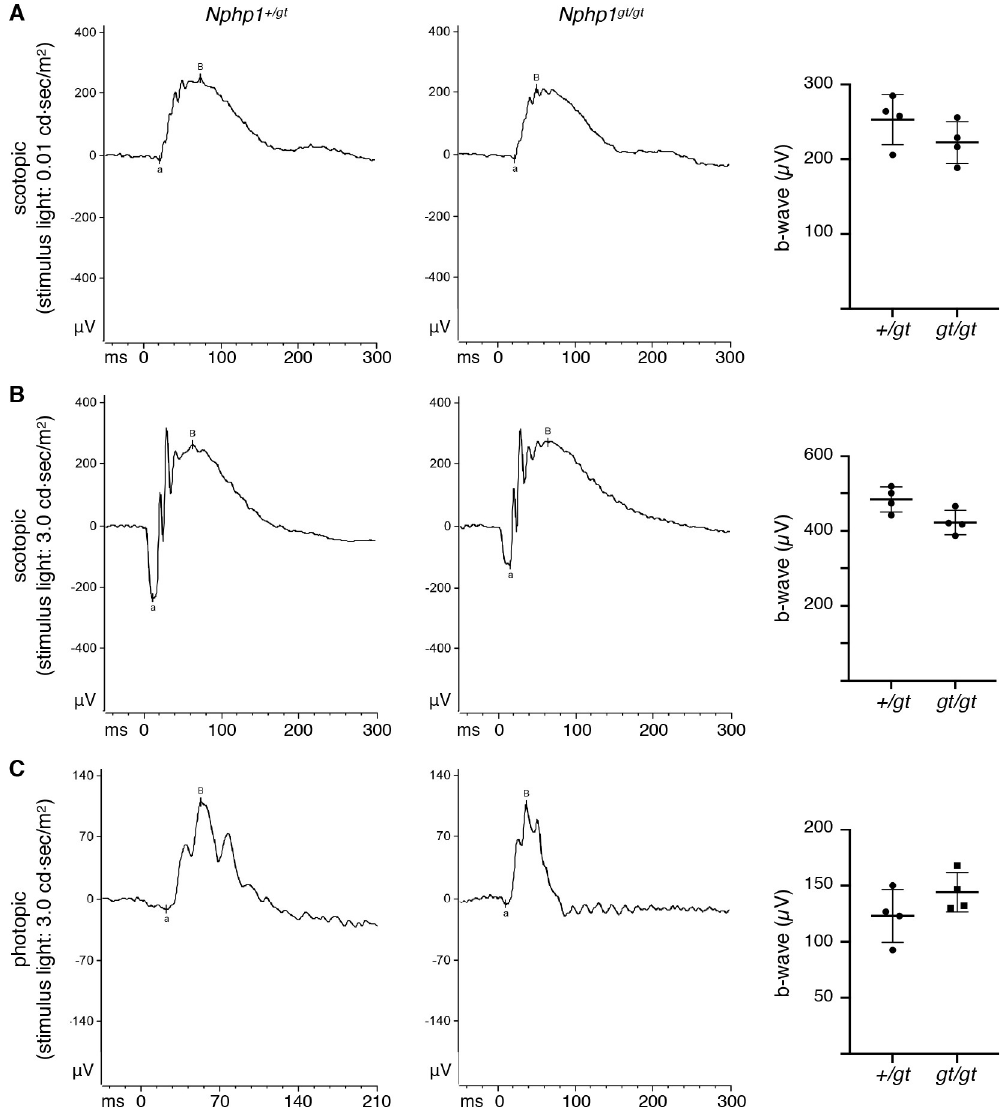
Fig 3. ERG responses of Nphp1 gt/gt mouse retinas. Representative scotopic (A and B) and photopic (C) ERG recordings (average of 15 responses) from 2-month-old Nphp1 +/gt and Nphp1 gt/gt mice are shown. Stimulus light intensities are shown on the left. Each data point in the scatter plots (right) represents the average of ERG b-wave amplitudes of two eyes from individual animals (n = 4). Means ± SD are marked by horizontal lines. Scotopic ERGs were obtained with (A) 0.01 cd � sec/ m 2 and (B) 3.0 cd � sec/m 2 flashes after overnight dark adaptation. Photopic ERGs (C) were obtained with 3.0 cd � sec/m 2 flashes in the presence of 9.0 cd � sec/m 2 background light after 10 minutes of light adaptation.